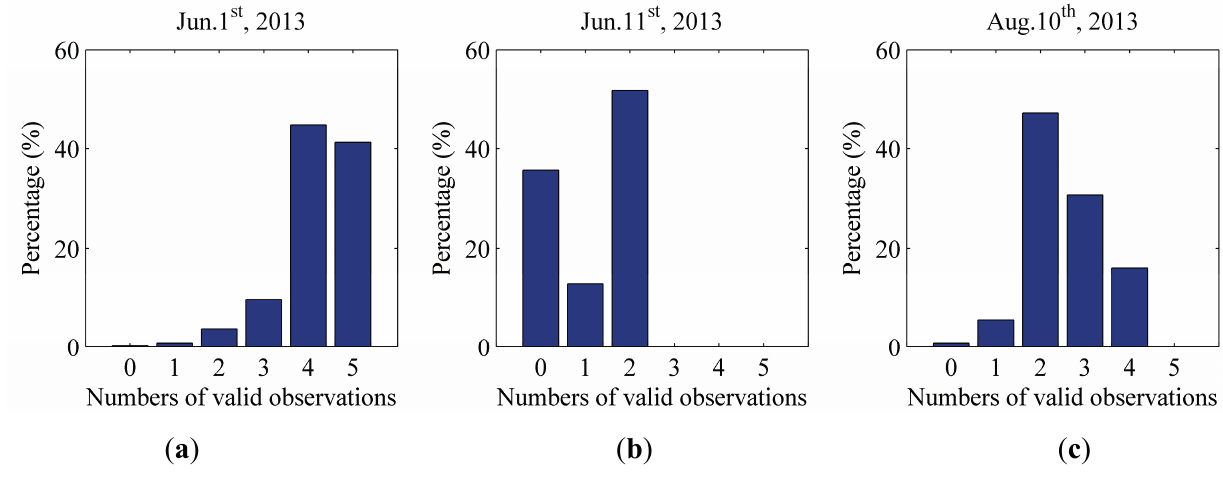
Figure 6. Statistical distributions of valid observations during three special observation periods: ( a ) 1 June 2013; ( b ) 11 June 2013; and ( c ) 10 August